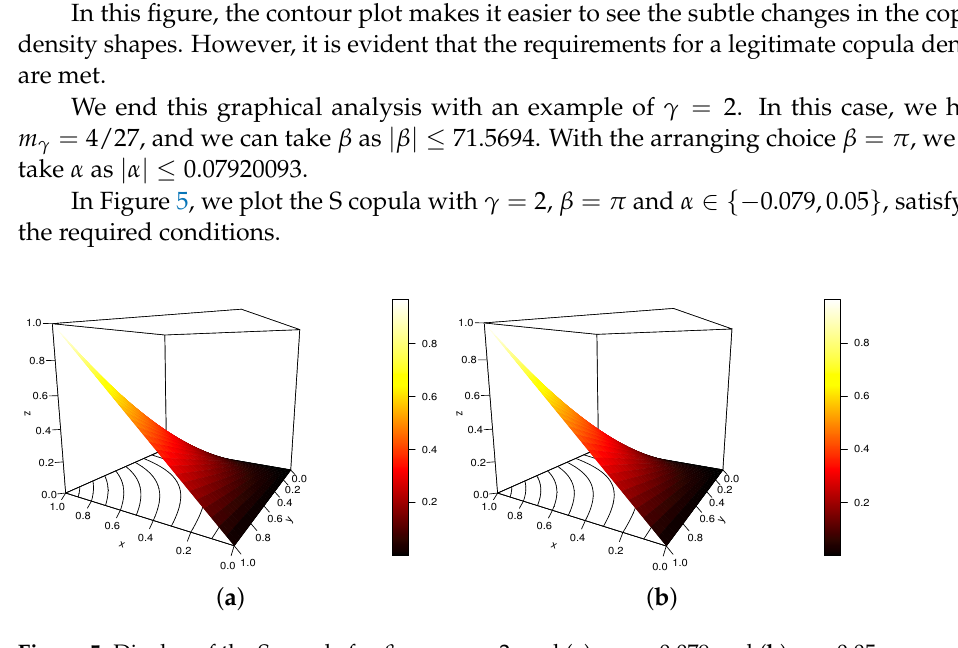
Figure 5. Display of the S copula for β = π , γ = 2, and ( a ) α = − 0.079 and ( b ) α = 0.05. The contour plot and the intensity of the red color zone are the key differences. Figure 6 completes Figure 5: we plot the S copula density with γ = 2, β = π and α ∈ {− 0.079, 0.05 } .